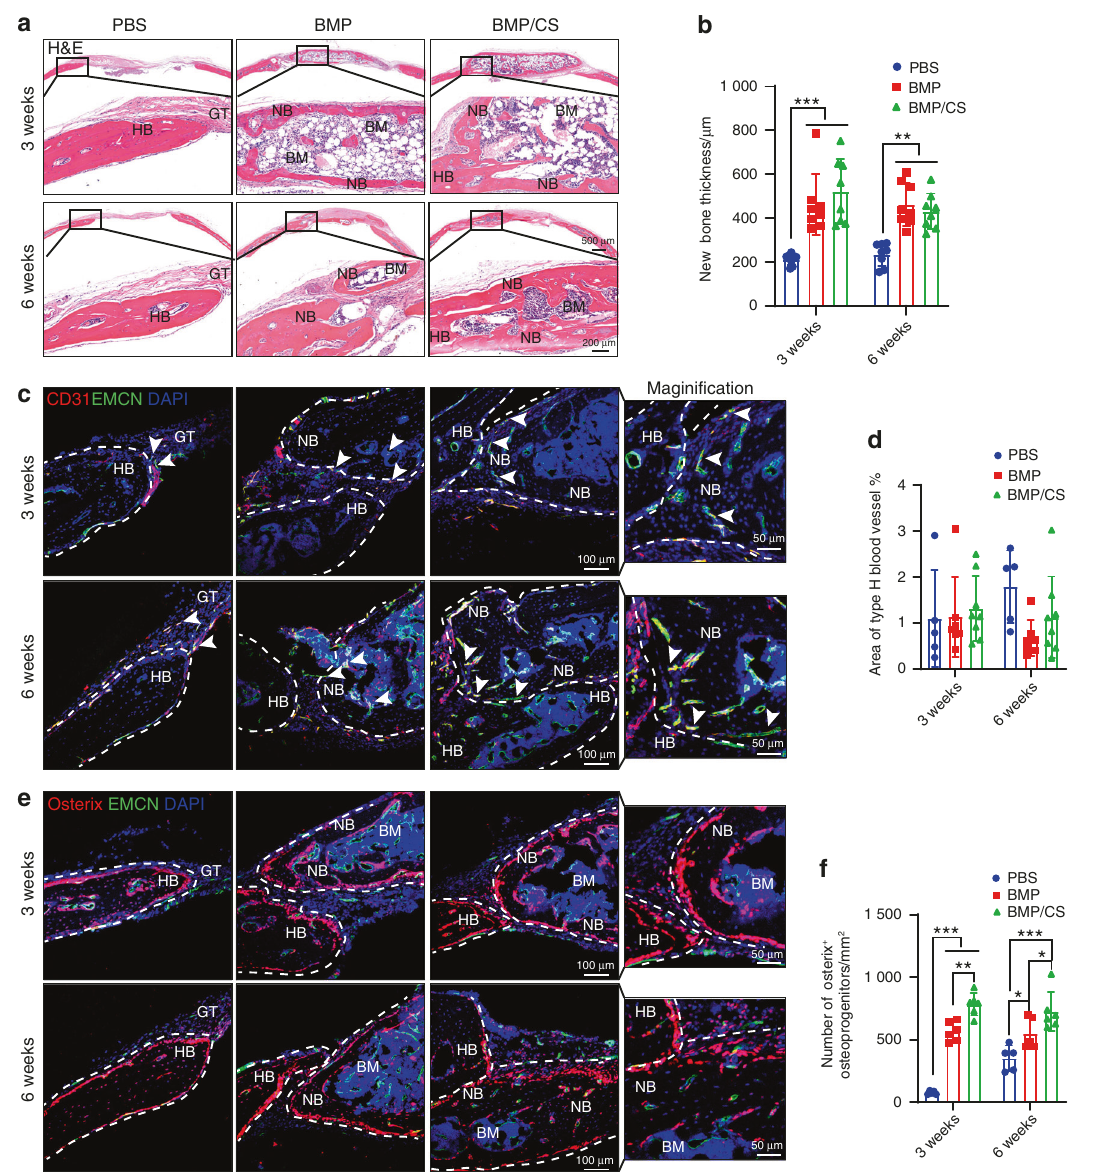
Fig. 6 Induced PTs enhance osteogenesis and osseointegration during autologous transplantation for calvarial defect repair. a , b H&E staining ( a ) and quantitative analysis ( b ) were used to assess the integration of transplanted PTs with host bones (HBs) ( n = 8). For PT in the PBS group, only new bone differentiated from HBs was observed. For PT in the BMP group, the mineralized HBs and the newly generated bones were partly separated by soft fi brous tissue. In contrast, HBs completely integrated with newly generated bones differentiated from the transplanted PTs in the BMP/CS group. c – f Immuno fl uorescence staining and quantitative analysis of type H blood vessels (EMCN + CD31 + , yellow; c , d ) and Osterix + osteoprogenitors (red; e , f ) in the PBS, BMP, and BMP/CS groups at weeks 3 and 6 after autogenic transplantation in young mice. Bone marrow BM, new bone NB, host bone HB, granulation tissue GT. EMCN-positive cells are green, CD31- and Osterix-positive cells are red, and DAPI is blue (nucleus). The white arrowhead indicates type H blood vessels ( c ). The white dashed line indicates the host bone or new bone area ( c , e ). Scale bar (top: low magni fi cation, 1 mm; bottom: high magni fi cation, 200 μ m; a ) and (left: low magni fi cation, 100 μ m; right: high magni fi cation, 50 μ m; c , e ). Data are presented as the mean ± SD. * P < 0.05, ** P < 0.01, *** P < 0.001, two-way ANOVA followed